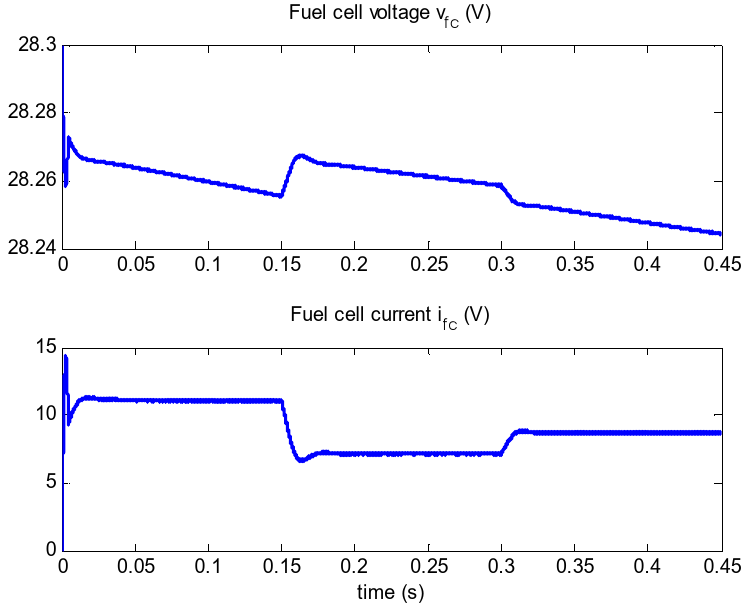
Figure 20. Fuel cell voltage and current in the presence of load resistance changes.